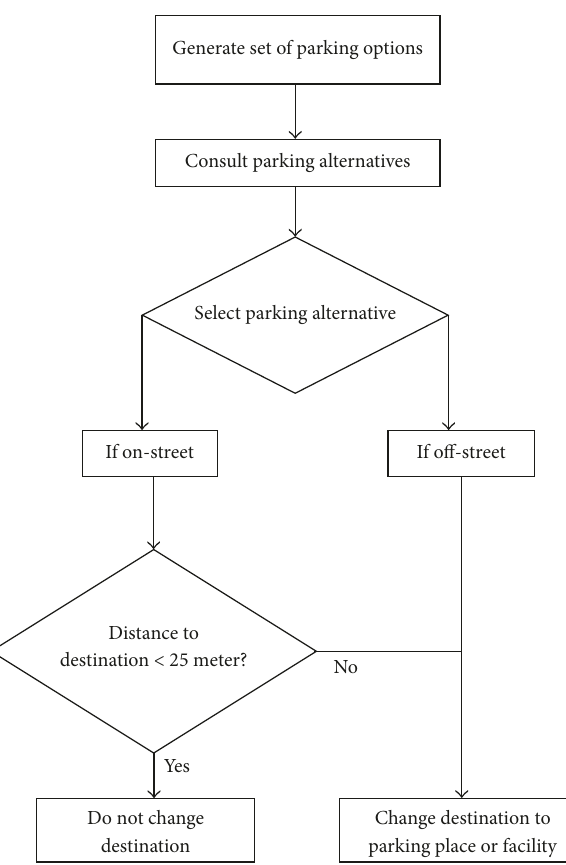
Figure 2: Graphical representation of the parking choice